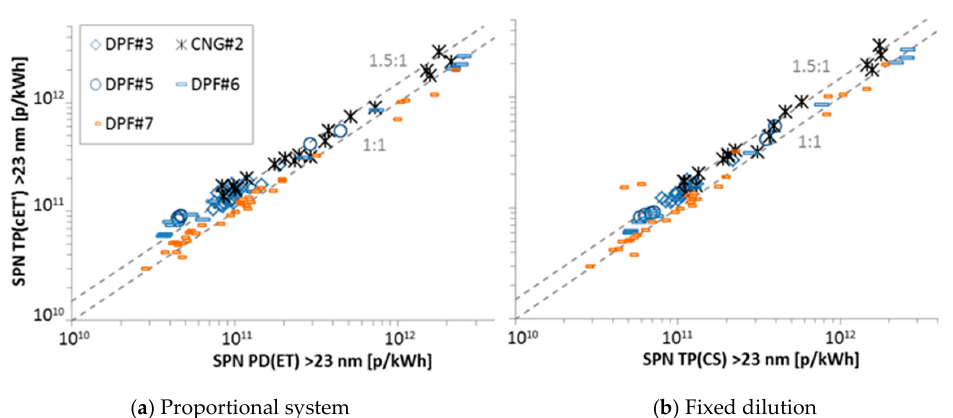
Figure 8. Comparison of > 23 nm emissions measured with the system with cold pre-diluter at the tailpipe TP(cET’) with ( a ) the PMP system with evaporation tube at the proportional system PD(ET), ( b ) the “Golden” system with catalytic stripper at the tailpipe TP(CS) for various tests and